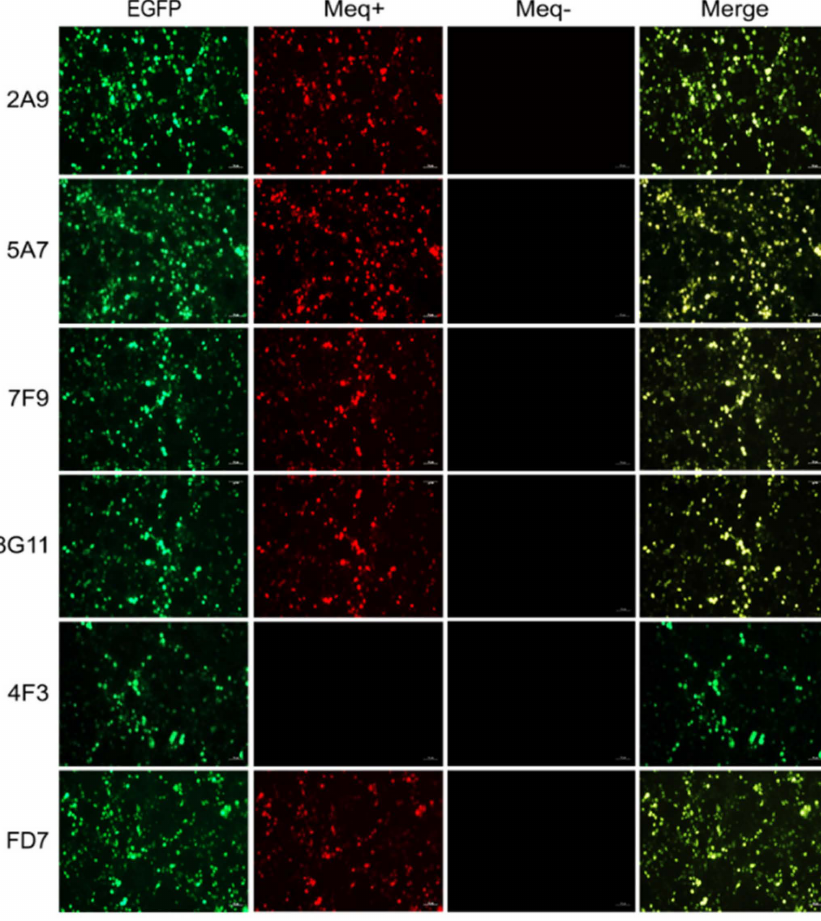
Figure 3. Staining of the Meq proteins overexpressed in 293T cells by immunofluorescence assay. The 293T cells transfected with the recombinant or empty plasmids, pEGFP-N1-Meq (Meq+) and pEGFP-N1 (Meq-), were fixed at 48 h post transfection, and then incubated with the candidate Meq antibodies and DyLight 594 labeled Goat Anti-Mouse IgG sequentially. The anti-Meq mAb FD7 served as a positive control. EGFP, enhanced green fluorescent protein with auto-fluorescence in green; Meq, MDV − 1 specific oncoprotein stained in red; Merge, merged image in yellow. (Scale bar = 50 µ